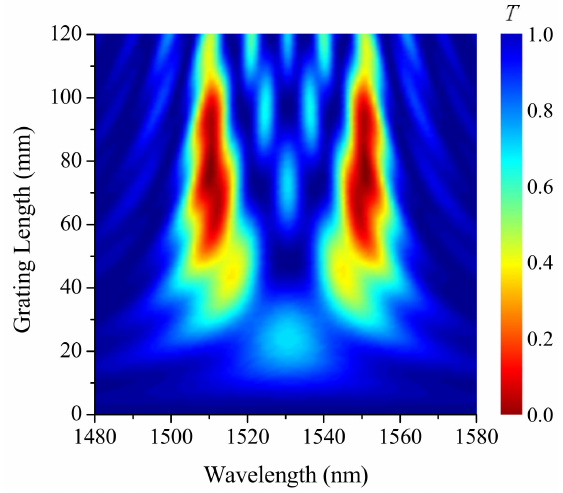
Figure 6. Evolution of transmission spectra with increasing grating length, when the acoustic front is in its center z 0 = L /2, for η = 0 mm and s 0 = 18 mstrain.